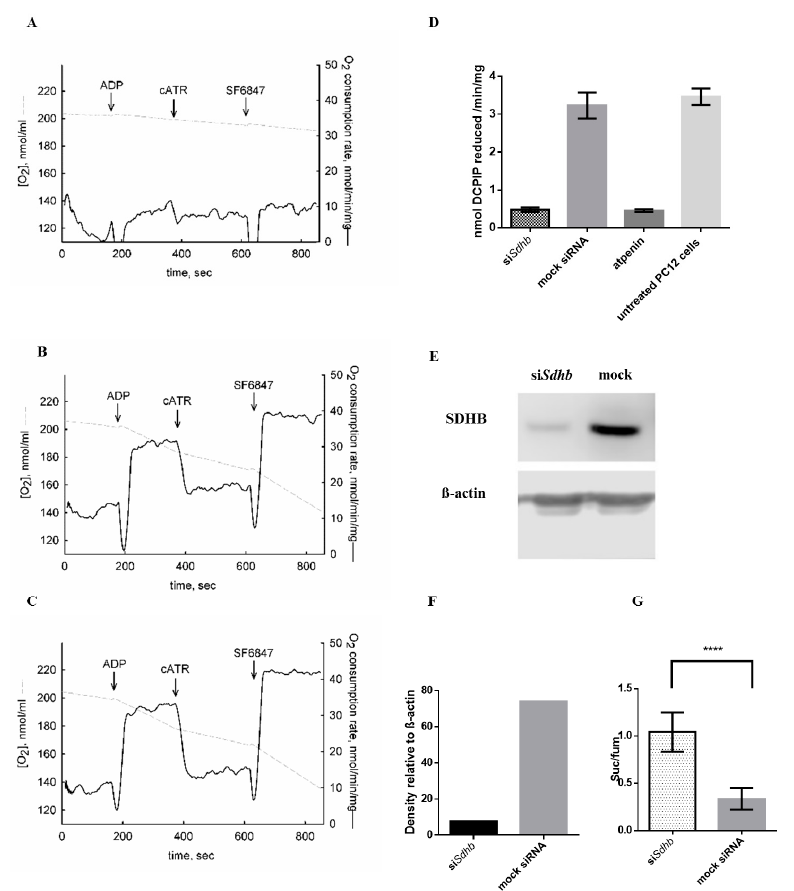
Figure 1. Effects of Sdhb knockdown in PC12 cells. ( A–C ) Oxygen consumption PC12 cells. Grey trace represents the negative time derivative of oxygen concentration, divided by mitochondrial mass per